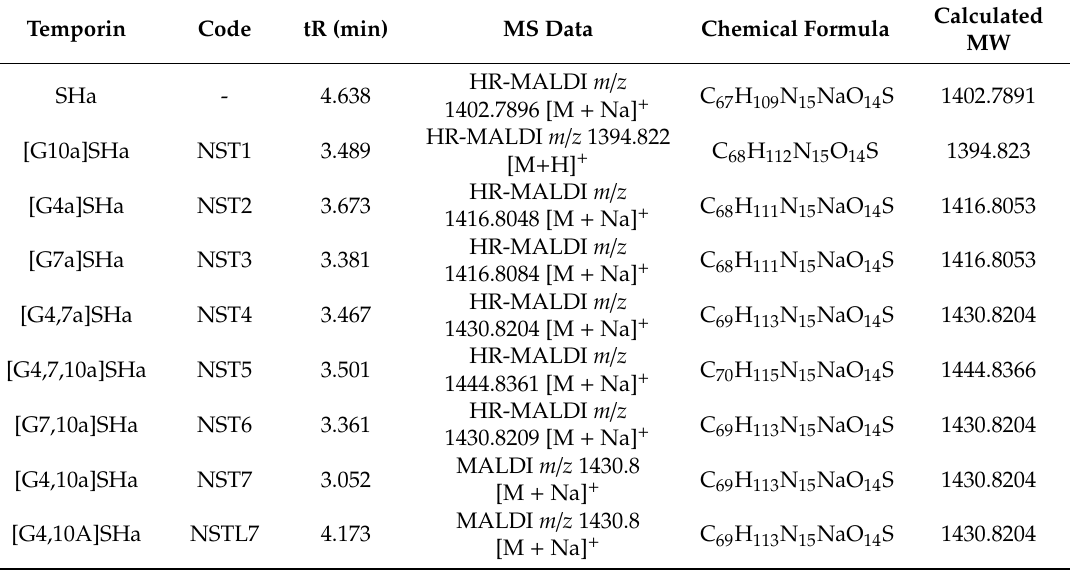
Table 2. Peptide Specifications. tR (retention time); MS (Mass spectrometric); MW (Molecular